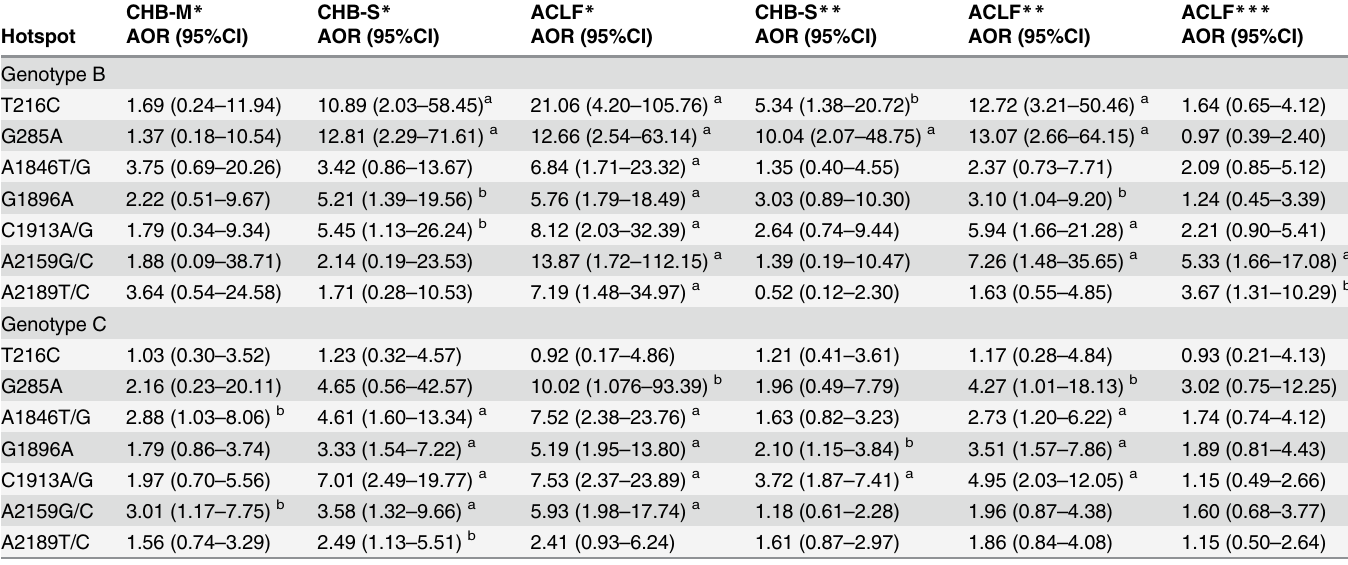
Table 4. The risks of CHB-M, CHB-S, and ACLF cases with 7 site mutations on the basis of genotype B and genotype C as compared with ASCs, CHB-M and CHB-S respectively.